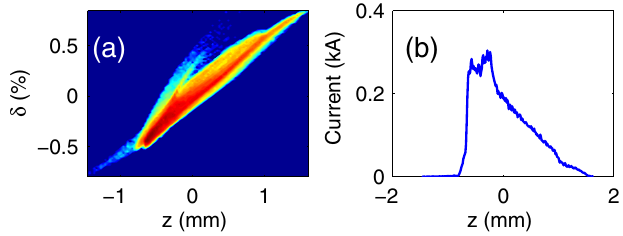
FIG. 14. Example of longitudinal phase space (left) and asso- ciated linearly ramped current profile (b) obtained downstream of the EEX beam line. The beam Lorentz factor is (cid:9) ’ 33 : 4 and the rms bunch length is 490 (cid:14) m . The initial distribution used for this calculation is the triangular-shaped distribution with a dipole moment (right column in Fig.